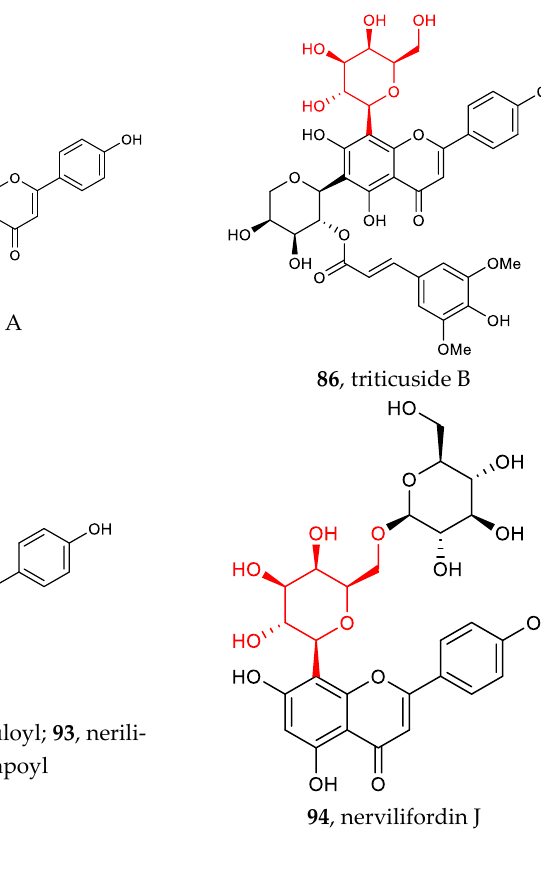
Figure 1. Chemical structures of flavonoid 6- or 8- C - β -D-glucopyranosides ( 1 - 80 ) and flavonoid 4′ - C - β -D-glucopyranoside ( 81 ).